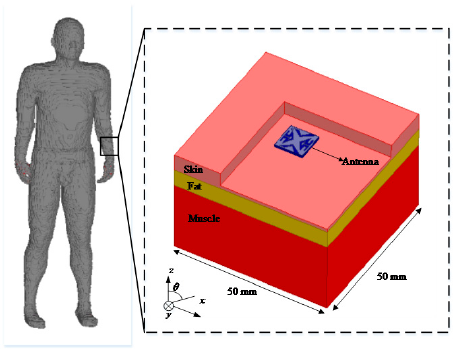
Figure 1. Simulation environment of the proposed